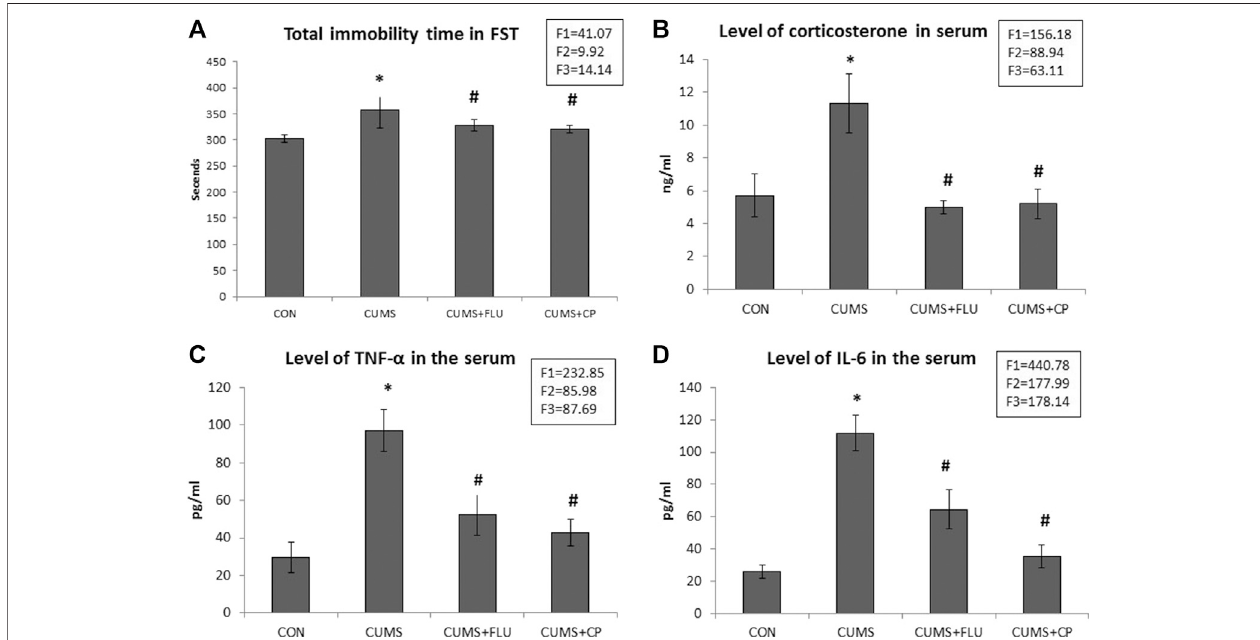
FIGURE1| Immobilitytimeduringtheforcedswimmingtest(FST) (A) ,serumcorticosteronelevel (B) ,TNF- α serumlevel (C) ,andIL-6serumlevel (D) inthestudied groups.Dataareanalyzedusingmixed-modeltwo-wayANOVAbasedontheBonferroniposthoctest.Resultsareexpressedasmean ± SD( n (cid:1) 10),dF (cid:1) 36,F1 (cid:1) effect of stress, F2 (cid:1) effect of treatment, F3 (cid:1) interaction between stress and treatment. A p value < 0.05 was considered signi fi cant. * signi fi cance versus the control group (CON), # signi fi cance versus the chronic unpredictable mild stress (CUMS) group. CON: control, CUMS: chronic unpredictable mild stress, Flu: fl uoxetine, CP: Cucurbita pepo